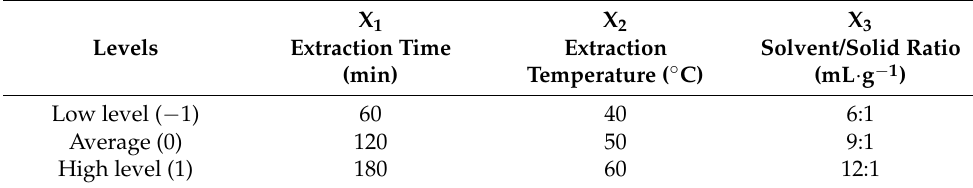
Table 3. The p -values ( p < 0.05) and the regression coefficient (R 2 > 0.95) were used to as- sess the significance of the model. The regression coefficients (R 2 = 0.989 for oxypeucedanin hydrate and R 2 = 0.987 for byakangelicin) indicated that only 1.0% of the variations were not explained by the model and that the model had high reliability (Table